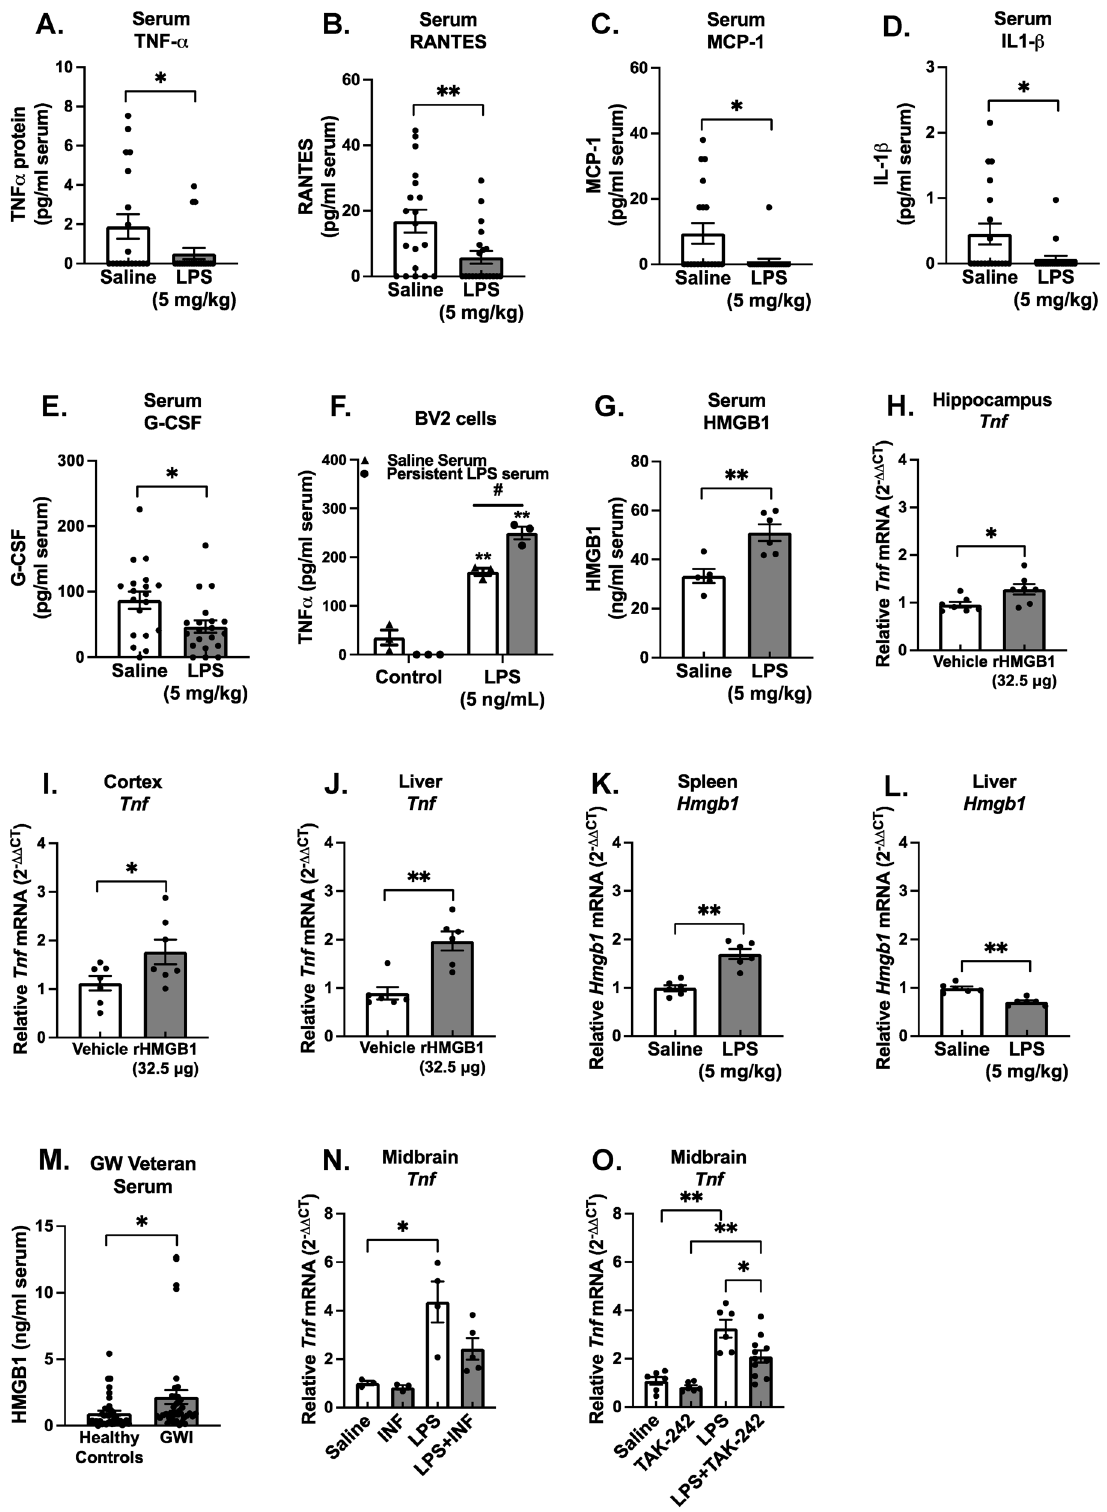
prophylactic against sarin nerve gas (Supplementary Table